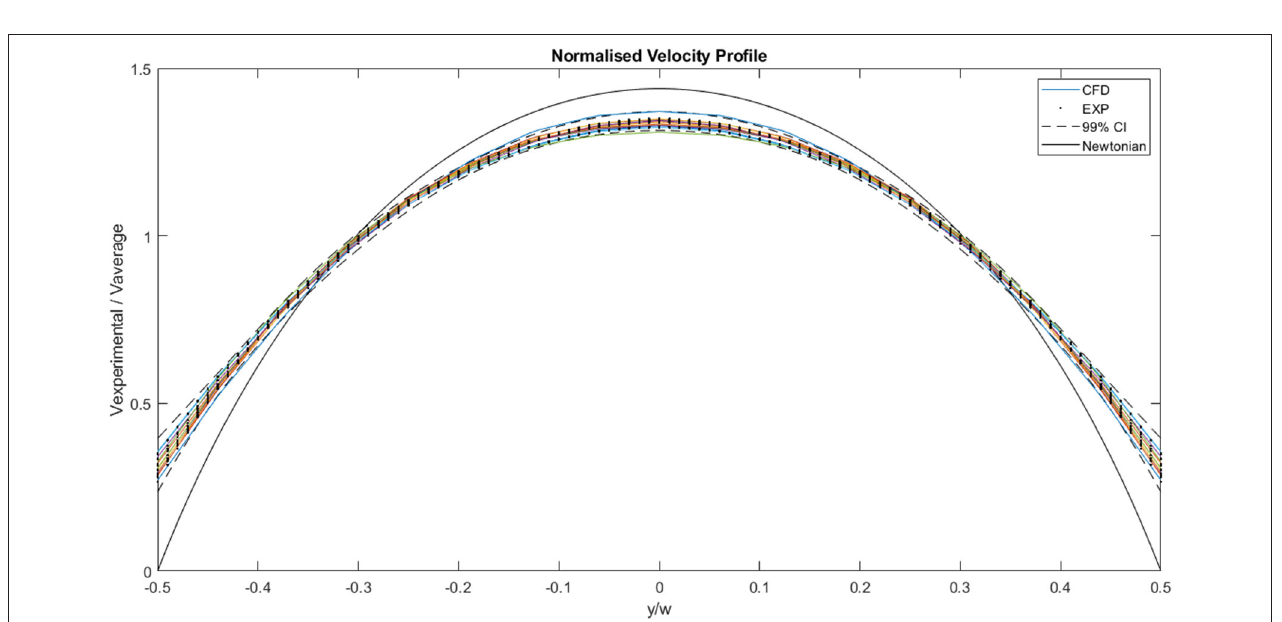
FIGURE 10 | Comparison of normalized experimental and two-dimensional CFD data. The solid lines represent CFD values, the dots represent experimental values, the dashed lines indicate the 99% confidence interval for those experimental values and the black solid line represents the analytical, Newtonian solution.